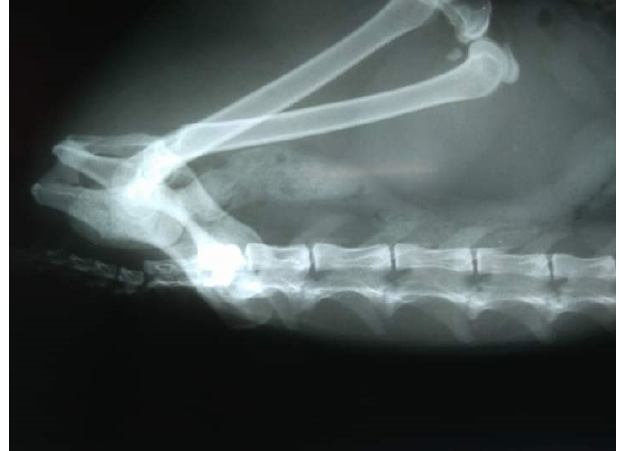
Figure 6. Radiography revealed fracture/luxation of S3 and